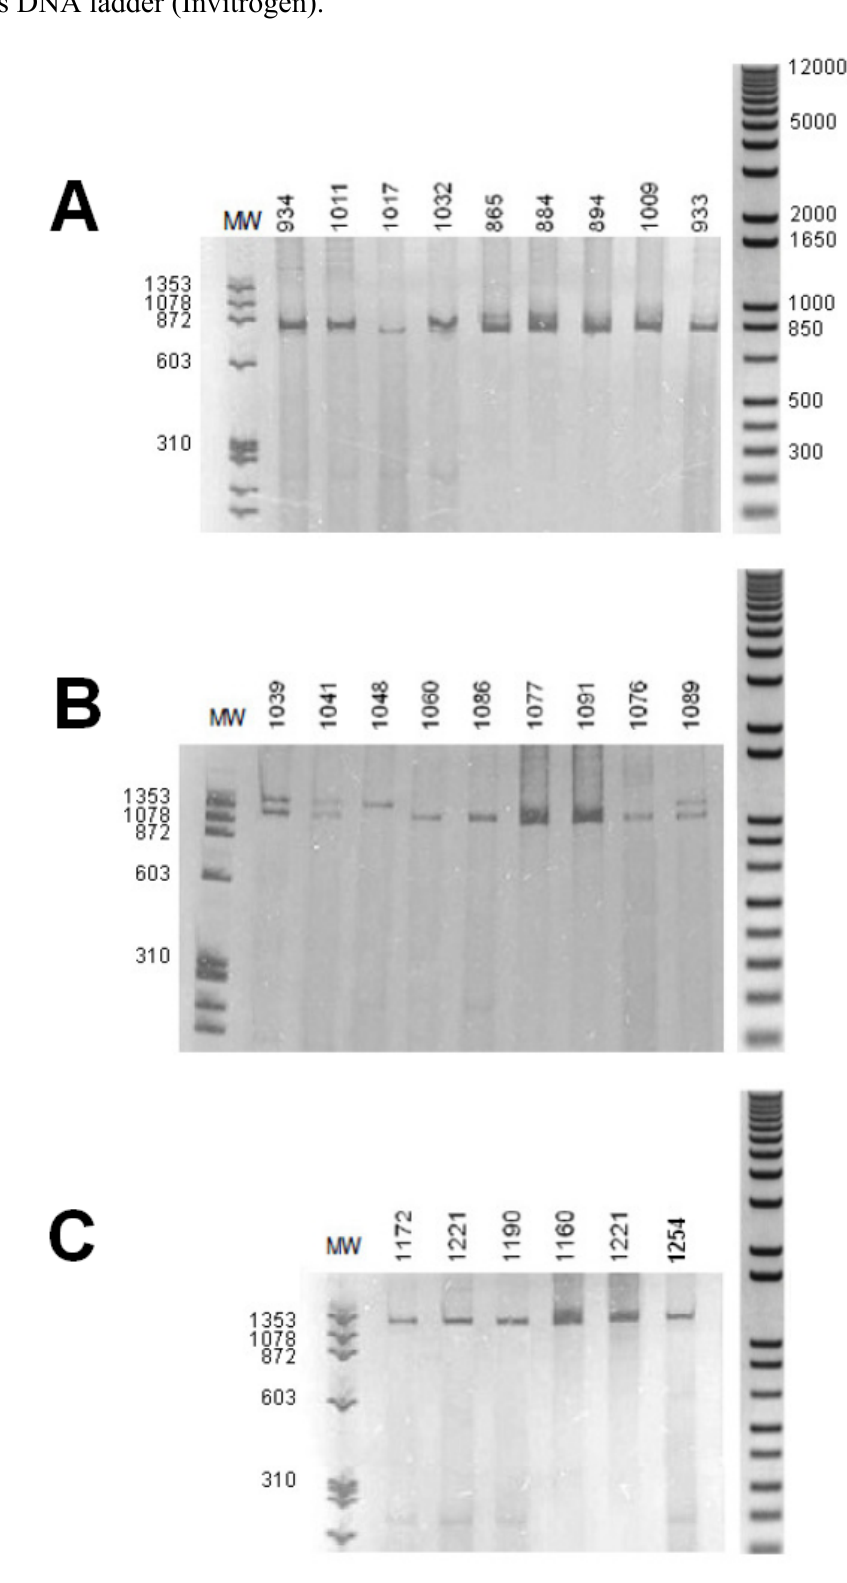
Figure 3. Polyacrylamide gel electrophoresis with silver stain. Amplification of intron 3 of the myoglobin gene. ( A ) B. glabrata ; ( B ) B. straminea ; ( C ) B. tenagophila . Numbers above the lane are one different individual. MW = molecular weight (base pairs) of  X174/ Hae III digested (Amersham Biosciences). Right: molecular weight (base pairs) of 1 kb Plus DNA ladder